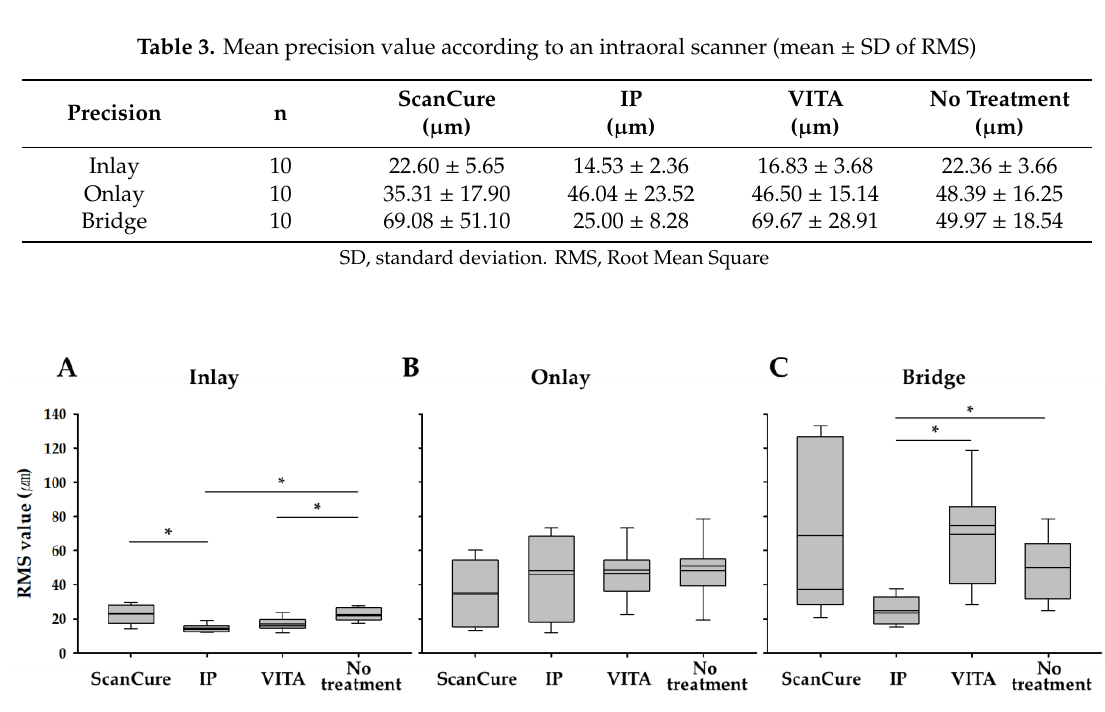
Figure 4. Box plots of the RMS values (precision, n = 10) for the four experimental groups (ScanCure, IP, VITA, no treatment, * p < 0.0083 by Bonferroni correction method) in three reference models. ( A ) inlay model, ( B ) onlay model, ( C ) bridge model.